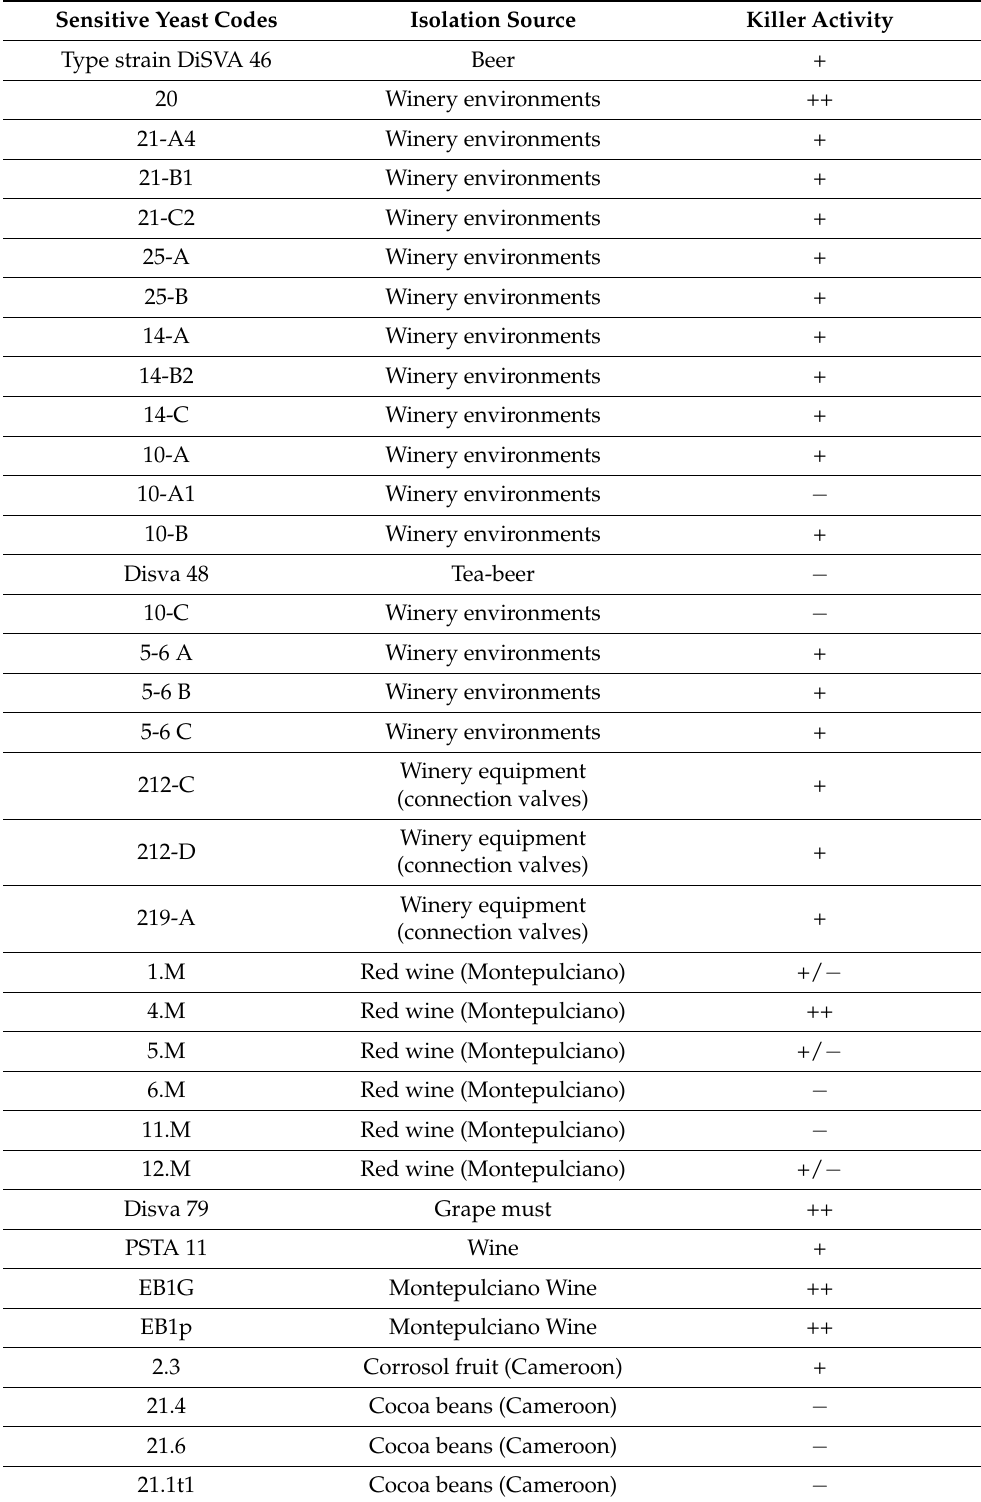
Table 1. List of Brettanomyces strains used and sources from which they were isolated. In the third column, the symbols report the killer effect of mycocin WA18 on the related sensitive strains. Legend: ++ strong killer action (diameter of halo > 15 mm), + evident killer action (diameter of halo between 14 and 10 mm), +/ − weak killer action (diameter of halo < 10 mm and not persistent), − no killer